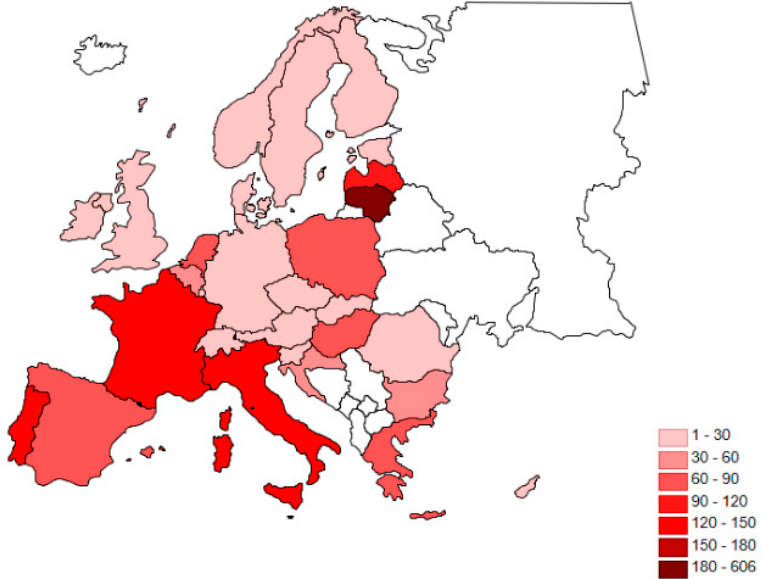
Figure 1. Structure of selected European countries by the number of firms trading on marketplaces per 100,000 inhabitants in 2019. Source: own elaboration based on data from Eurostat.